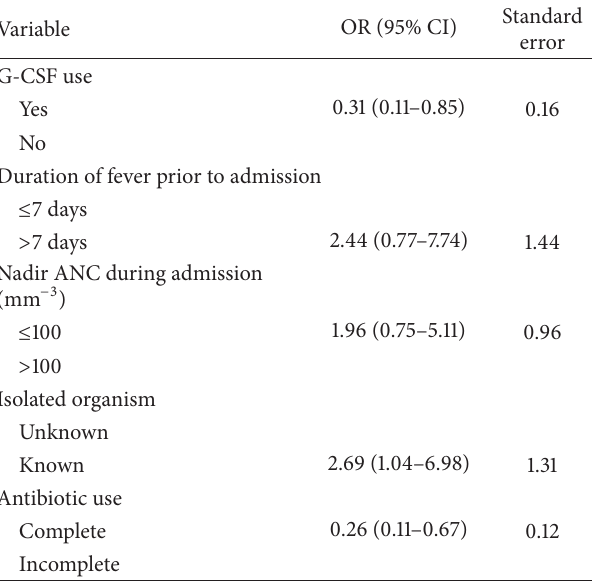
Table 5: Prognostic factors related to severe outcomes based on multivariate